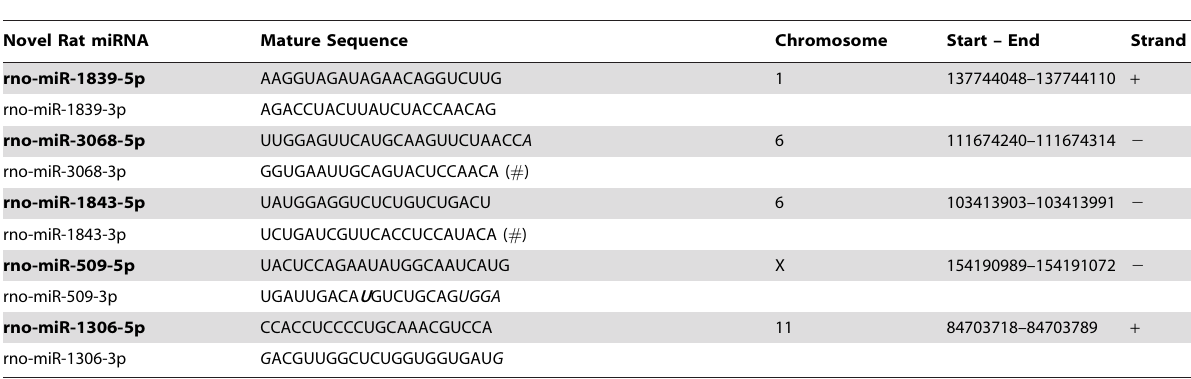
Table 1. Ten rat homologous miRNAs sequences and genome locations.